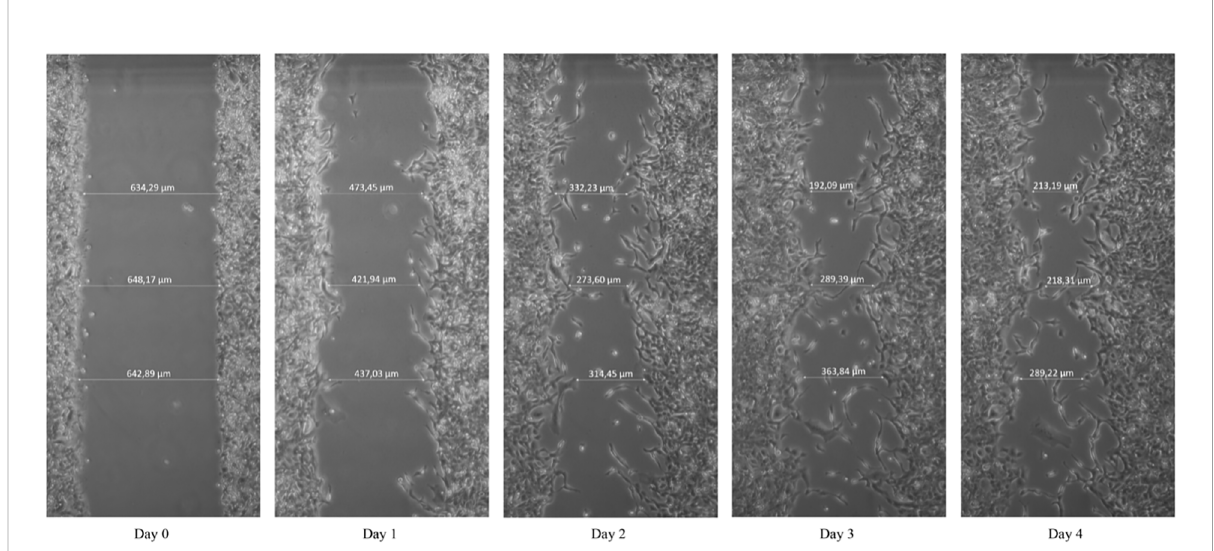
FIGURE 5 Scratch assay. Cells were scratched using a 10 µl pipet tip. Pictures were taken using an inverted microscope at ×10 magni fi